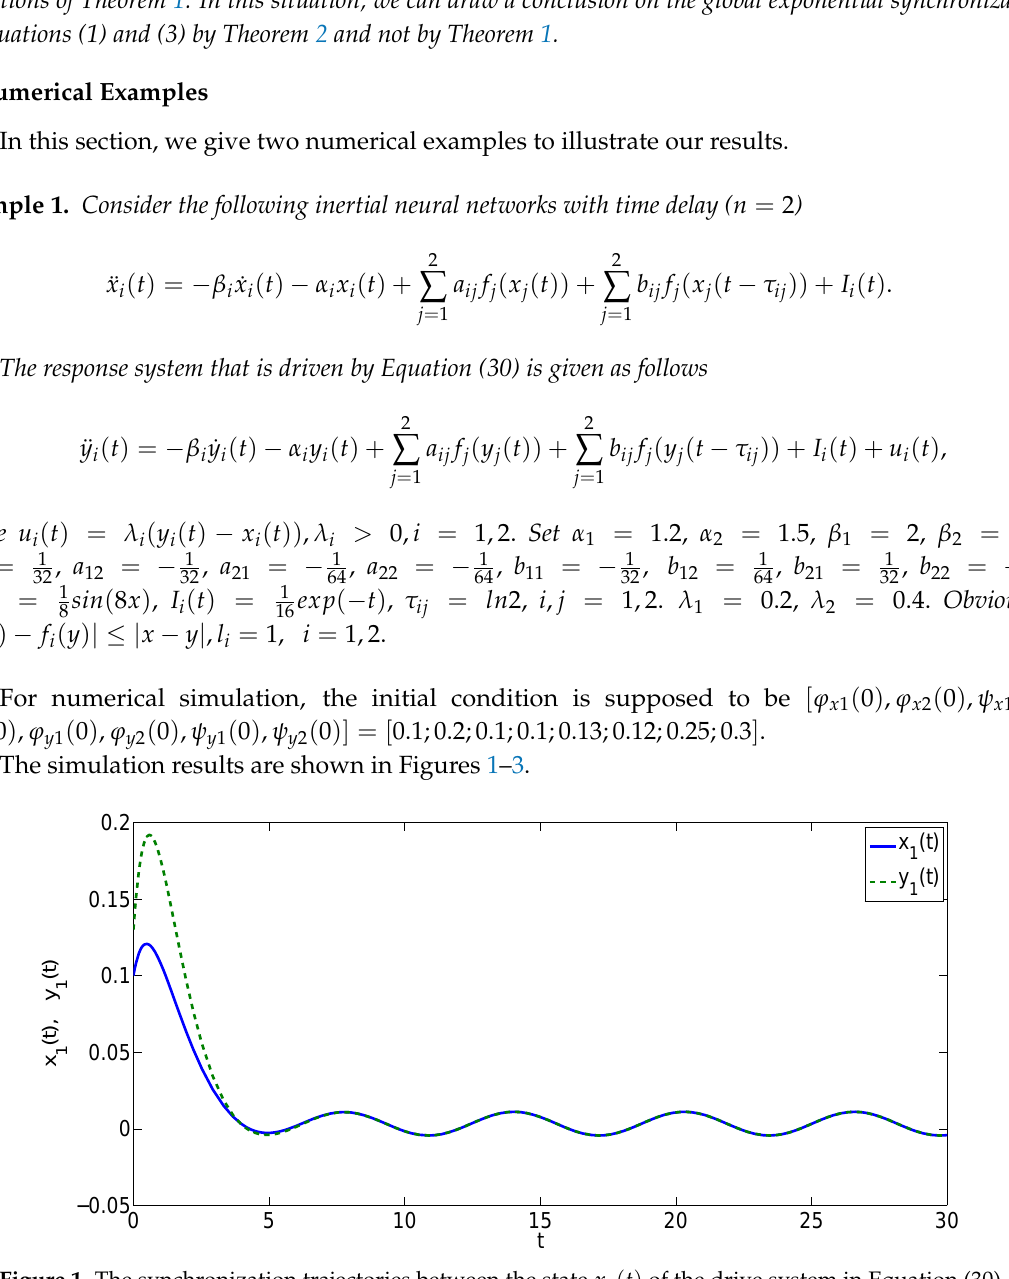
Figure 1. The synchronization trajectories between the state x 1 ( t ) of the drive system in Equation (30) and the state y 1 ( t ) of the response system in Equation (31) in Example